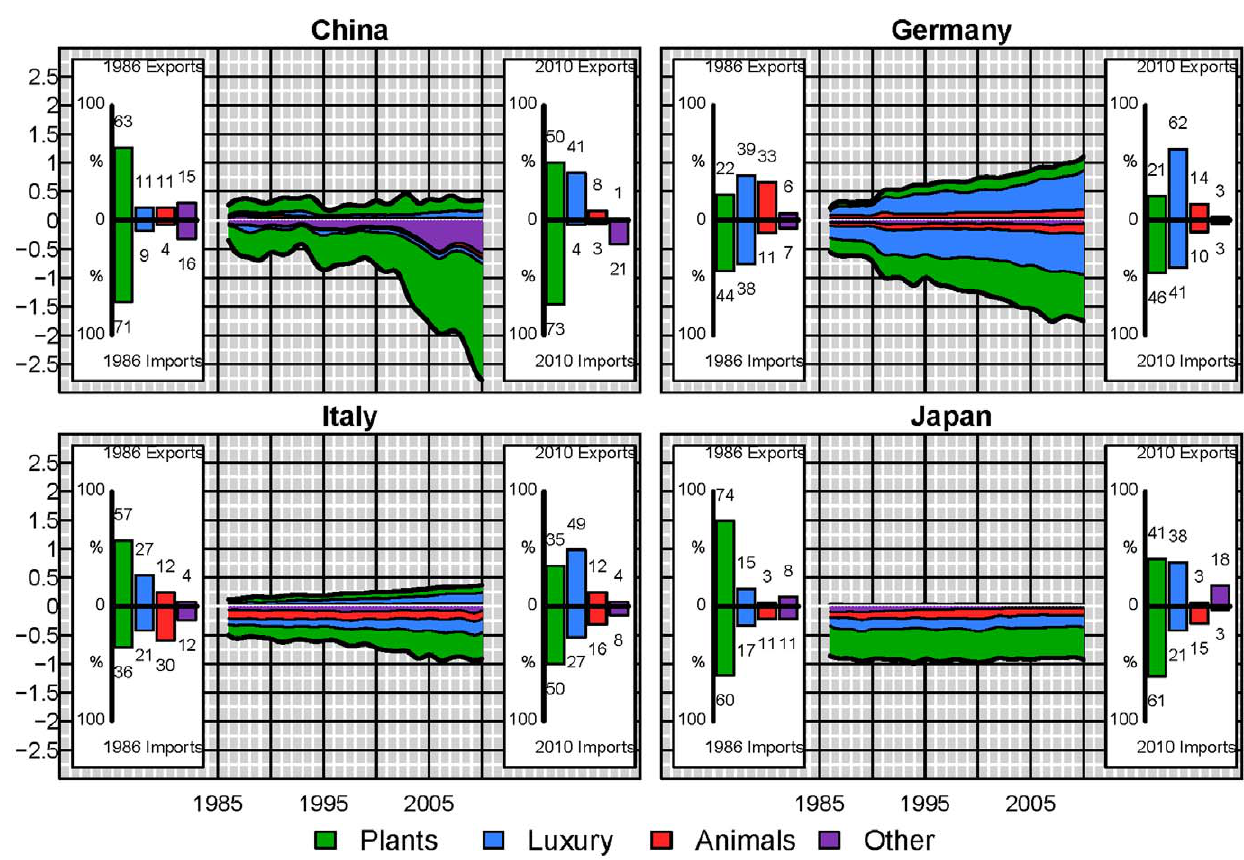
Figure 5. Detailed virtual water trade (10 11 m 3 ) by commodity type for China (mainland), Germany, Italy and Japan. Positive values refer to exports and negative values to imports. The insets indicate the percentage of virtual water imports or exports contributed by plant, animal, luxury and other products.